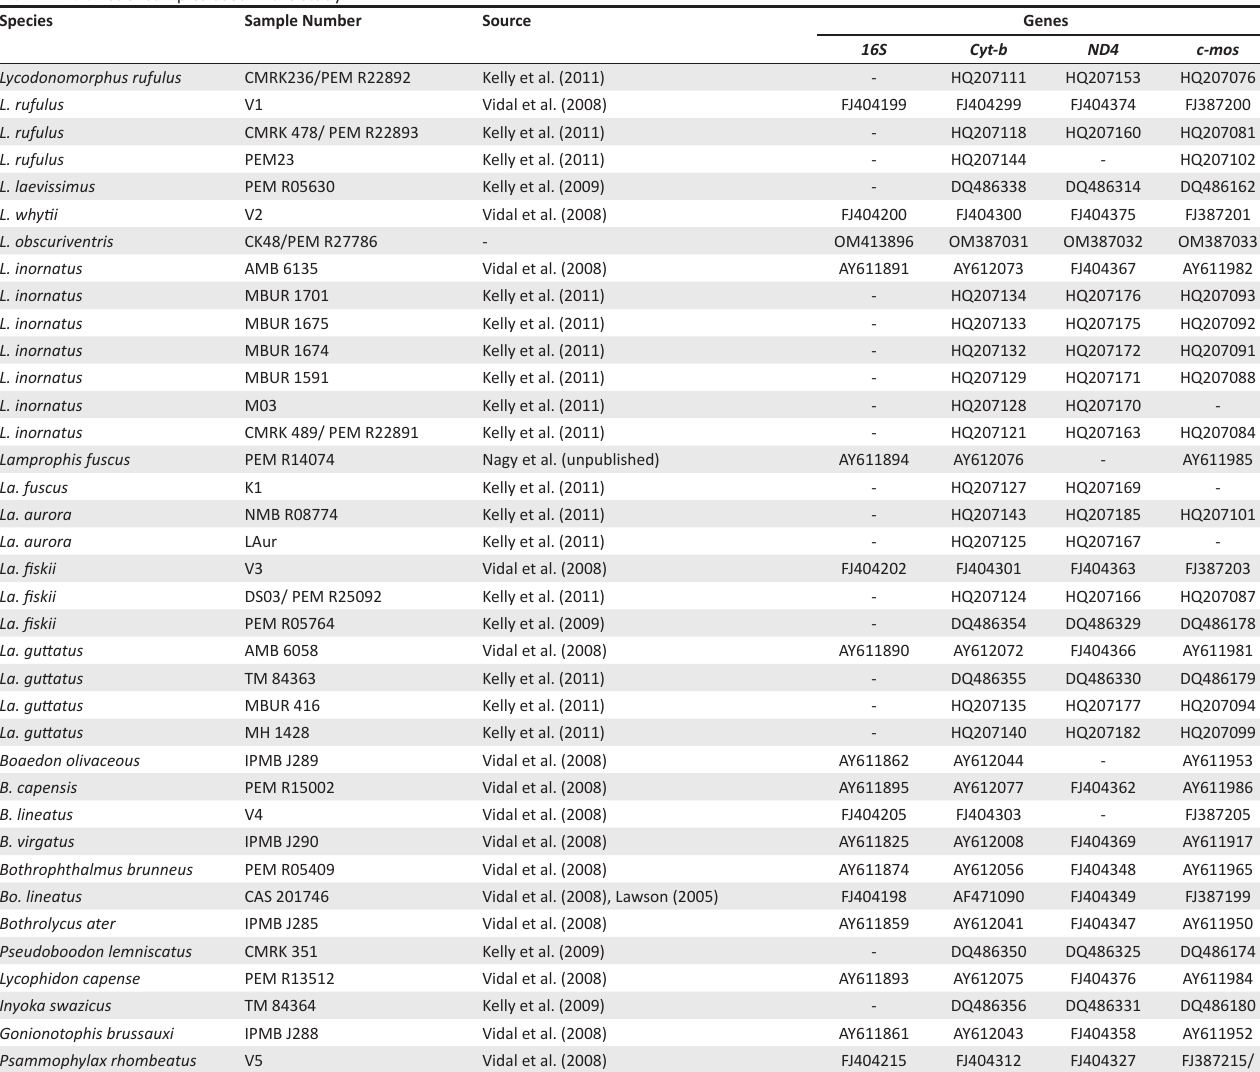
TABLE 1-A1: List of samples used in the study.